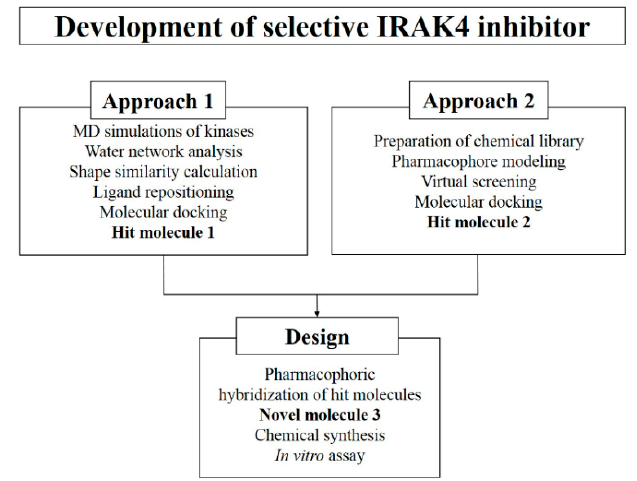
Figure 1. Flow chart illustrating the computer-aided design and development of a potent and selective IRAK4 inhibitor. Hit and designed molecules identified using different approaches are